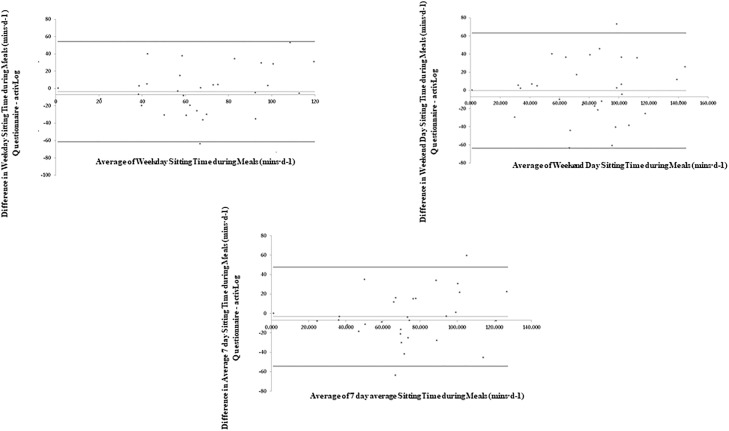
Bland-Altman plots of absolute agreement of sitting time during meal time (weekdays, weekend days and average of last 7 days) derived from the questionnaire with the equivalent variable derived from the criterion measure (combination of AP3M determined sedentary time and the domain specific log).